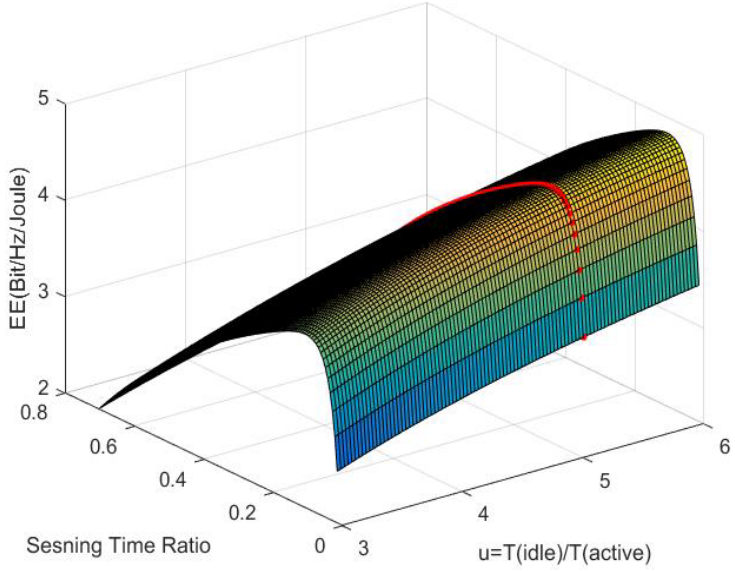
Figure 5. Example of three − dimensional EE optimization with PU’s idle/active ratio and sensing